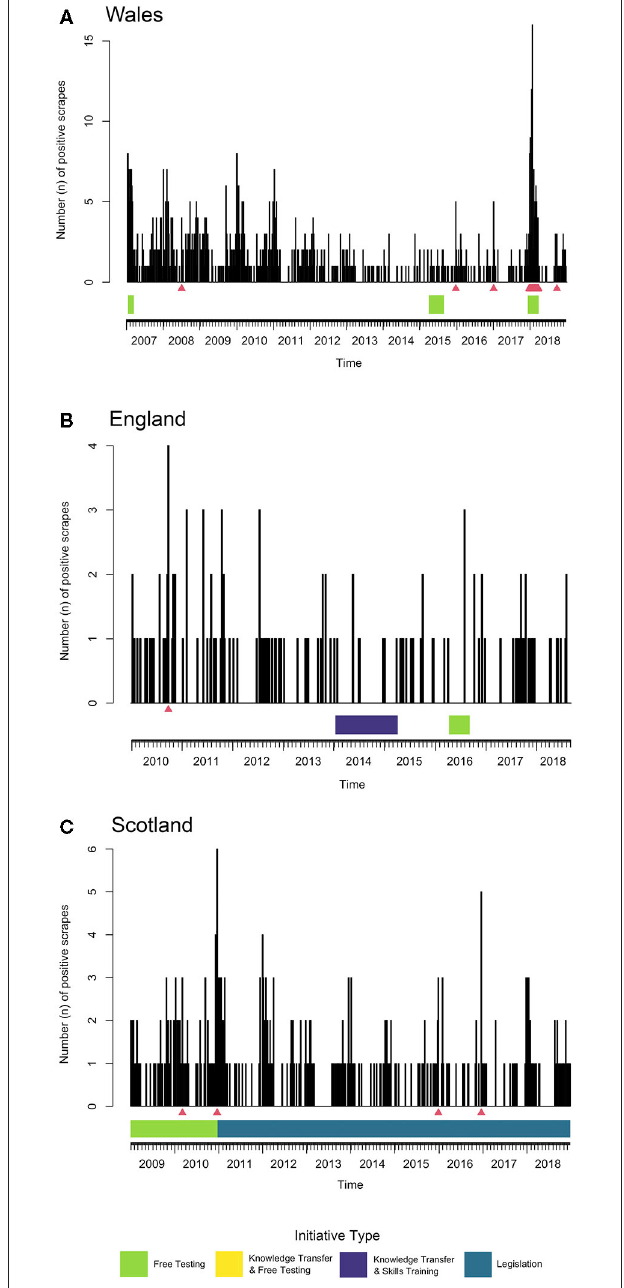
FIGURE 5 | Time-series plot with the Farrington algorithm applied to the count of VIDA positive scrapes in: (A) Wales from week 1 of 2007 to the end of 2018, using a reference period of week 27 of 2004 to the end of 2006; (B) England from week 1 of 2010 to the end of 2018, using a reference period of week 1 of 2006 to the end of 2009; (C) Scotland from the beginning of 2009 to the end of 2018, using a reference period from the beginning of 2005 to the end of 2008. Red triangles indicate alarms raised by the TADA, showing a significant deviation from the expected count. The coloured horizontal bars are a visual representation of targeted sheep scab disease control initiatives in place in that country. These include free testing (green), knowledge transfer & free testing (yellow), knowledge transfer & skills training (purple), and legislation (blue). For description of initiatives see Table 2